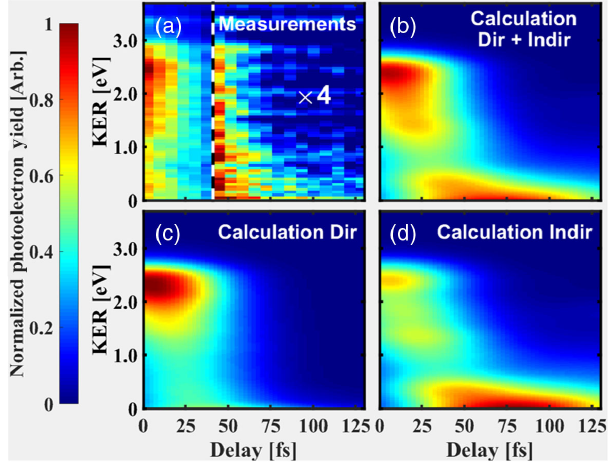
FIG. 2. Measured and simulated time-resolved photoelectron spectra. (a) TRPES from experimental measurement. (b) Simu- lated TRPES including all trajectories. (c) Simulated TRPES for direct (Dir) dissociation trajectories. (d) Simulated TRPES for indirect (InDir) dissociation